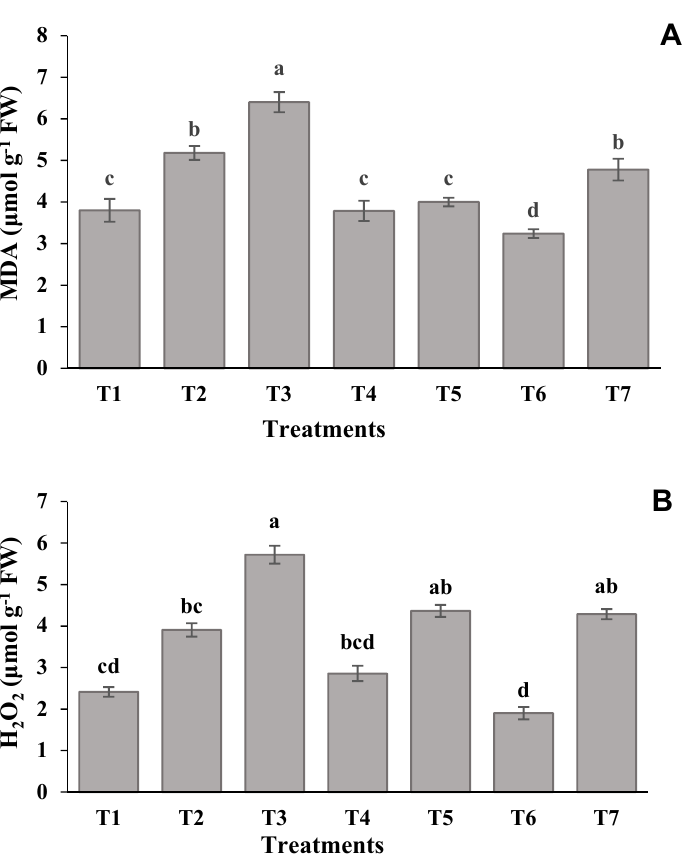
Figure 1. Effect of SNP on the ( A ) MDA content and ( B ) H 2 O 2 content in leaves of lentil plants under salinity stress. Data presented are the means ± SE ( n = 4). Different letters on the bars indicate significant differences among the treatments at p ≥ 0.05 for MDA and H 2 O 2 content. T1 = 0 mM of NaCl + 0 µ M of SNP (control); T2 = 50 mM of NaCl+ 0 µ M of SNP; T3 = 100 mM of NaCl + 0 µ M of SNP; T4 = 50 mM of NaCl + 50 µ M of SNP; T5 = 100 mM of NaCl +50 µ M of SNP; T6 = 50 mM of NaCl + 100 µ M of SNP; T7 = 100 mM of NaCl+ 100 µ M of SNP.